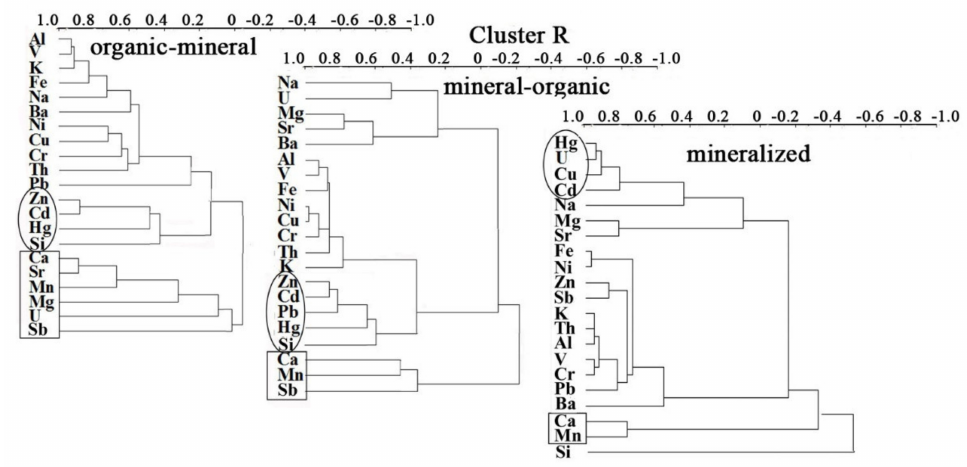
Figure 8. The dendrogram of the R-type cluster analysis, where analytical data on the contents of major (Si, Ca, Na, K, Al, Mg, Fe) and trace elements (Ti, P, Mn, Sr, Ba, Pb, Cd, V, Cu, Zn, Co, Ni, Cr, Hg, U, Th) in different types of sapropel sediments are used: organic–mineral; mineral–organic; mineralized. An oval is a group of organophilic elements; a rectangle is a group of